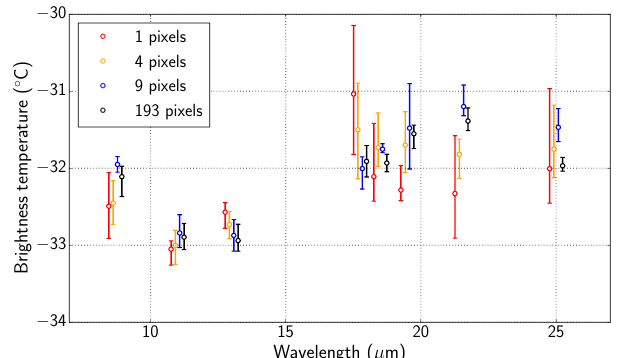
Figure 16. FIRR spectral brightness temperatures at 5.56km as in Fig. 7, except that measurements were averaged over a varying number of pixels, from 1 to 193. Error bars indicate measurement variability along four consecutive measurements. For each spectral band the four corresponding error bars are slightly displaced hori- zontally for sake of